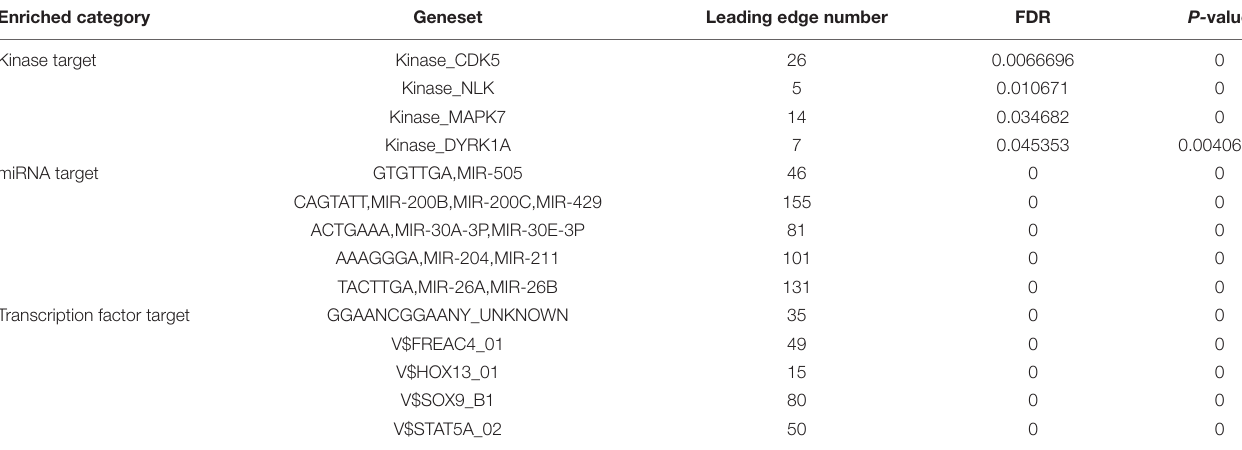
TABLE 1 | Kinase, miRNA and transcription factor-target networks of PDZD11 in LIHC (LinkedOmics). Enriched category Geneset